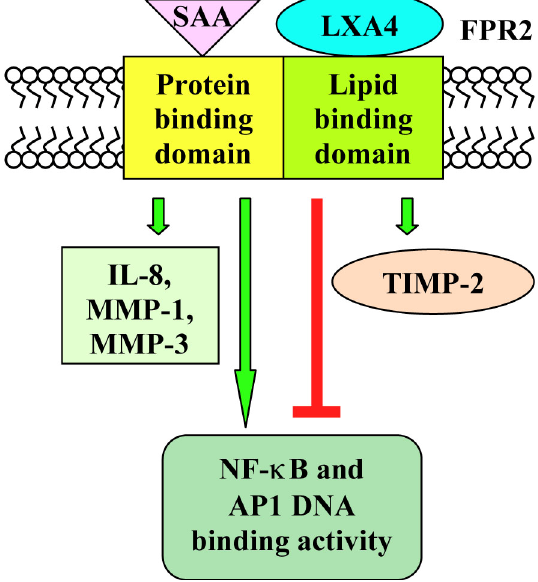
Scheme 1. Binding on FPR2 of LXA4 or serum amyloid A (SAA) have opposite effects on metalloproteinase expression and on NF- κ  and AP1 DNA binding activity. In human fibroblast-like synoviocytes, SAA promotes the production of metalloproteinase-1 and -3 (MMP-1 and MMP-3) and upregulates NF- κ B and AP1 DNA binding activity, by interacting with the protein binding domain of FPR2. On the other hand, LXA4 induces stimulation of tissue inhibitors of metalloproteinase-2 (TIMP-2) and inhibits NF- κ B and AP1 DNA binding activity, by interacting with the lipid binding domain of